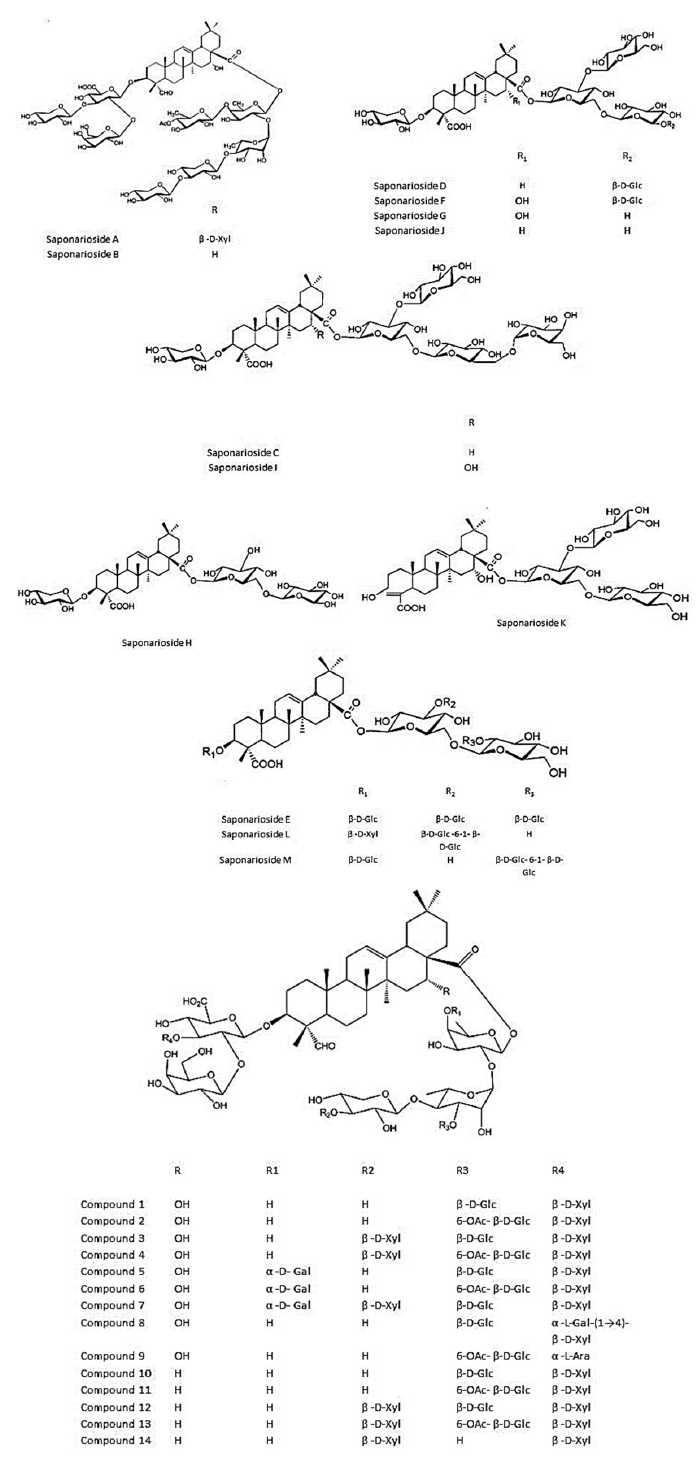
Figure 4. Structure of saponins of Saponaria